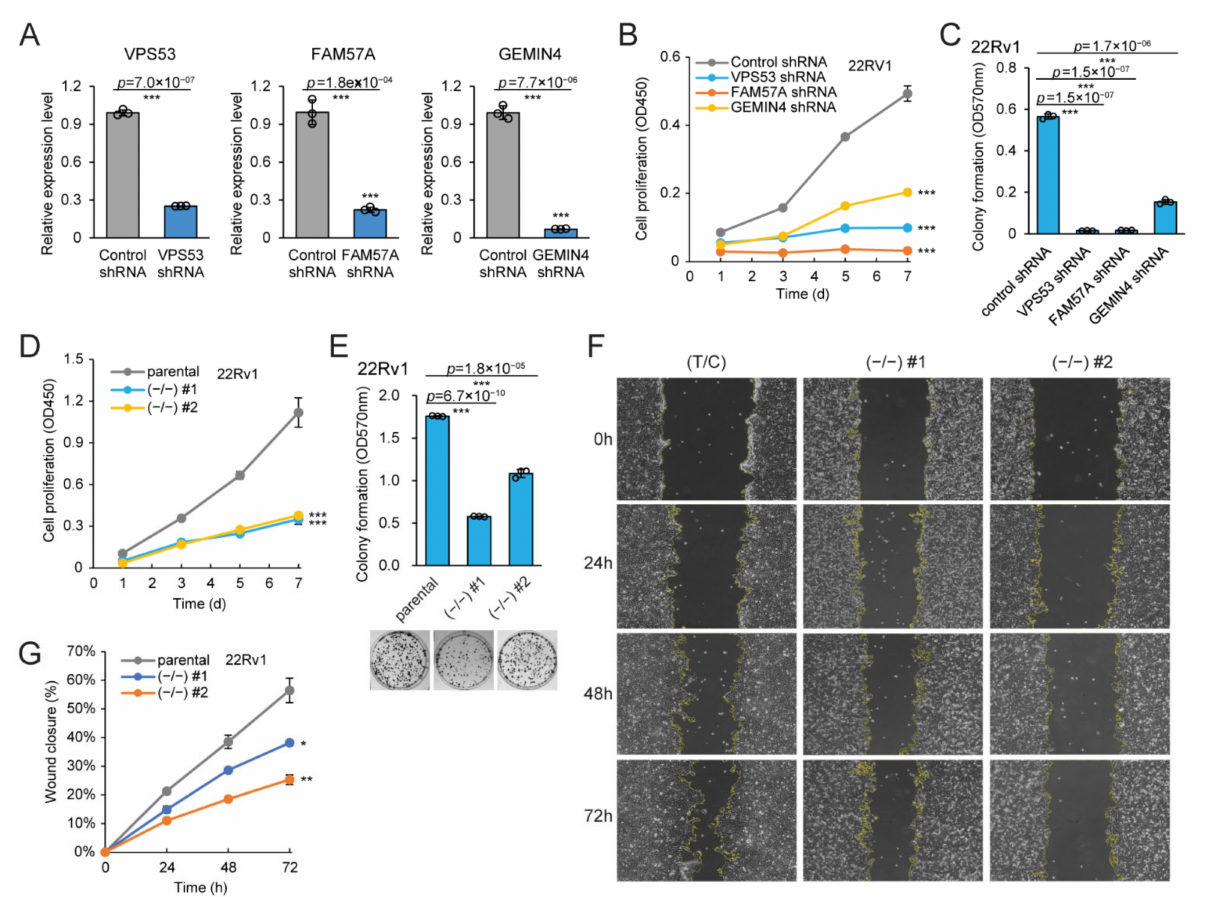
Figure 6. VPS53 , FAM57A , and GEMIN4 knockdown impede cancerous phenotypes. ( A ) Effect evaluation of lentiviral shRNAs targeting VPS53 , FAM57A , and GEMIN4 in 22Rv1 cells. Mean ± SD of three technical replicates. *** p < 0.001, two-tailed Student’s t -test. ( B ) Cell proliferation assay of 22Rv1 cells undergoing lentiviral shRNA gene knockdown targeting VPS53, FAM57A , and GEMIN4 , respectively. Cell viability was determined using the CCK-8 method at 1–7 d post-seeding. Mean ± SD of three biological replicates. *** p < 0.001, two-tailed Student’s t -test. ( C ) Colony formation assay of 22Rv1 cells undergoing lentiviral shRNA gene knockdown targeting VPS53 , FAM57A , and GEMIN4 . Cell colonies were quantified through the Crystal Violet staining method. Mean ± SD of three biological replicates. *** p < 0.001, two-tailed Student’s t -test. ( D ) Cell proliferation assay for the two genome-edited 22Rv1 cells with rs684232 site mutated through indels. Cell viability was determined using the CCK-8 method at 1–7 d post-seeding. Mean ± SD of three biological replicates. *** p < 0.001, two-tailed Student’s t -test. ( E ) Colony formation assay for the two genome-edited 22Rv1 cells. Cell colonies were quantified through the Crystal Violet staining method. Representative images from triplicate experiments on the bottom. Mean ± SD of three biological replicates. *** p < 0.001, two-tailed Student’s t -test. ( F ) Wound healing assay of the two rs684232 knockout 22Rv1 cell lines. Representative images from triplicate experiments. ( G ) The wound closure percentages in the wound healing assay experiments were quantified using Image J software. Mean ± SEM of three biological replicates. * p < 0.05, ** p < 0.01, two-tailed Student’s t